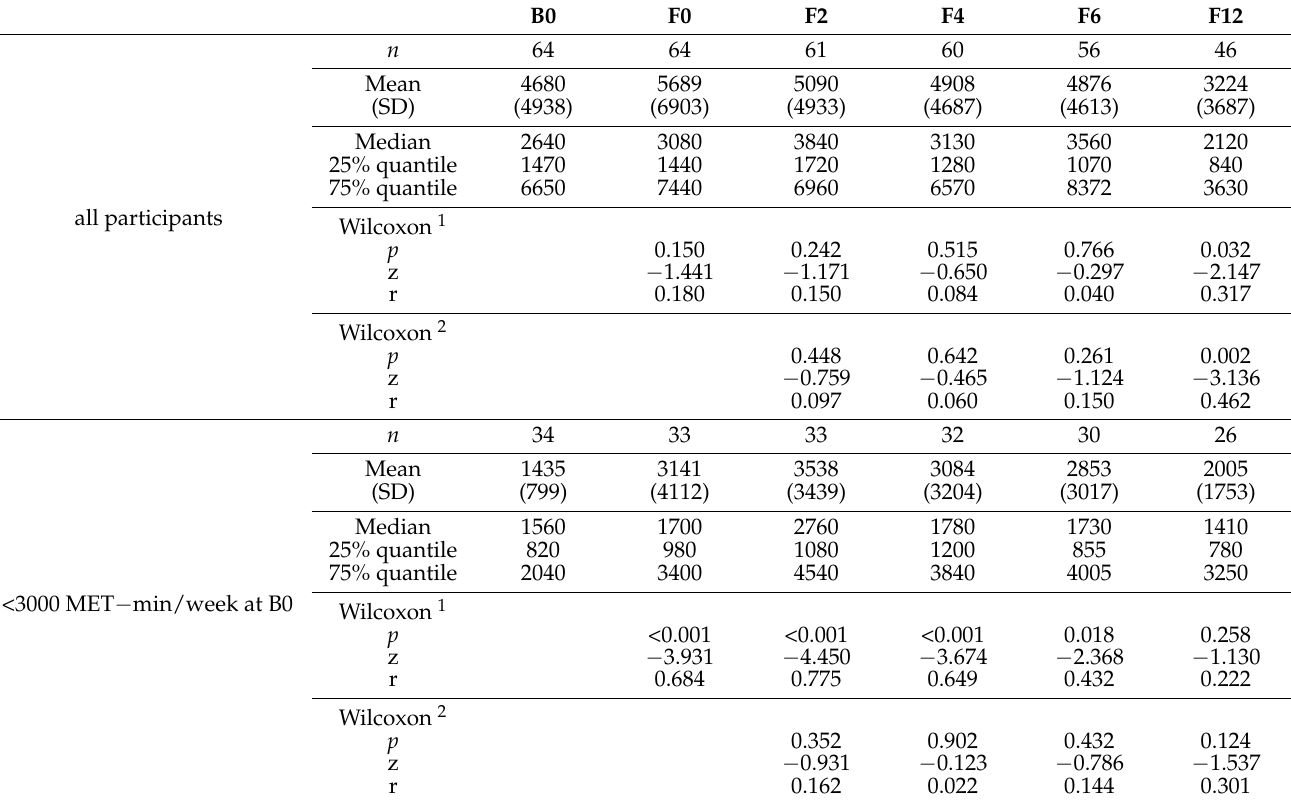
Table 2. Development of MET-minutes per week, using Wilcoxon signed-rank